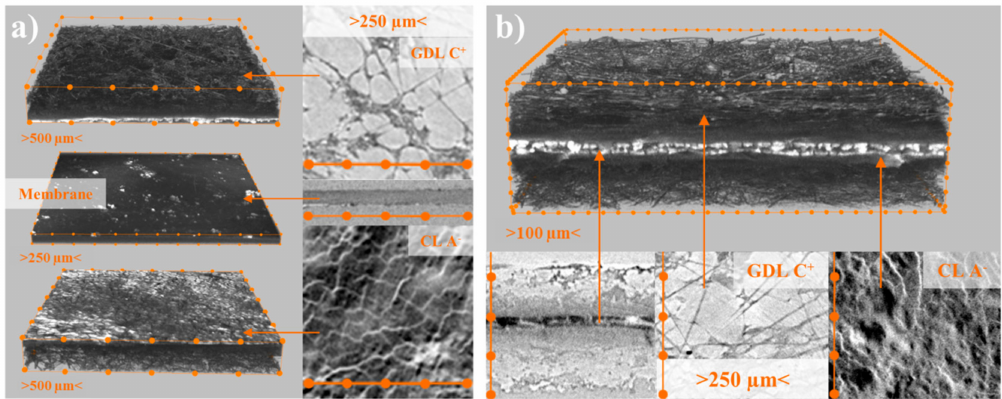
Figure 7. Reconstructed 3D images (CTVox) of the complete MEA: ( a ) FMT-A BoL and ( b ) FMT-A. Zoom-in areas are reconstructed 2D images (DataViewer) of single layers (GDL, Membran, CL).